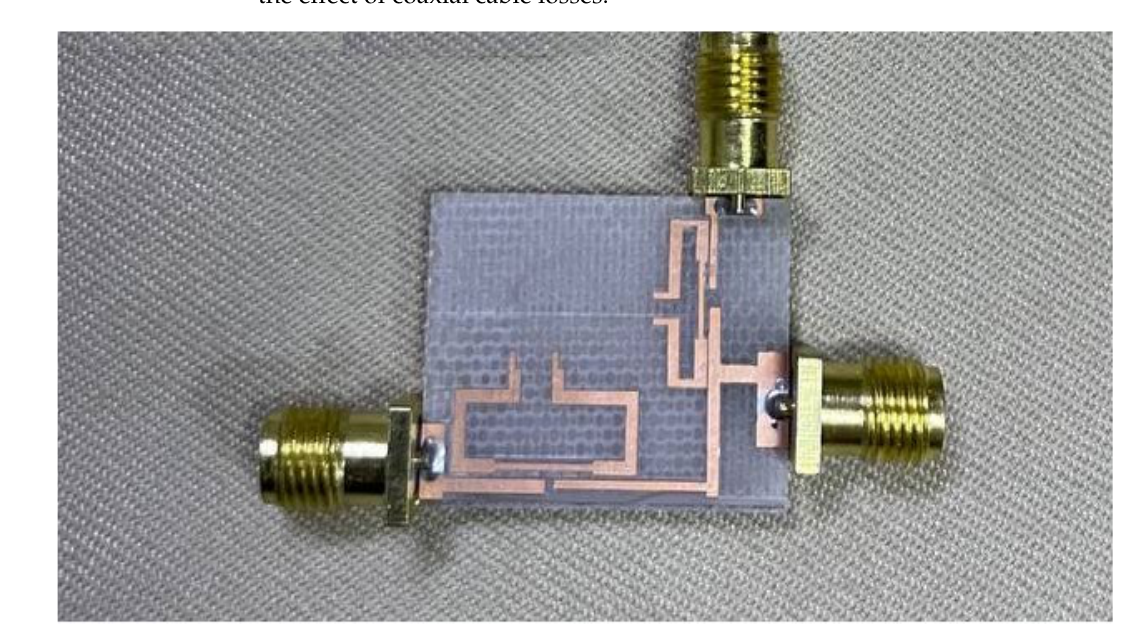
Figure 13 is a photograph of the microstrip diplexer after it was fully fabricated. In order to confirm the validity of the design simulations and test the operation of the diplexer, it was run through its paces on a Vector Network Analyzer (VNA). Figure 14 displays the measured and simulated frequency responses of the proposed diplexer. The simulated and measured results are consistent with one another. There are small differences because of VNA setup factors including the size of the diplexer, the quality of the SMA soldering, and the effect of coaxial cable losses.